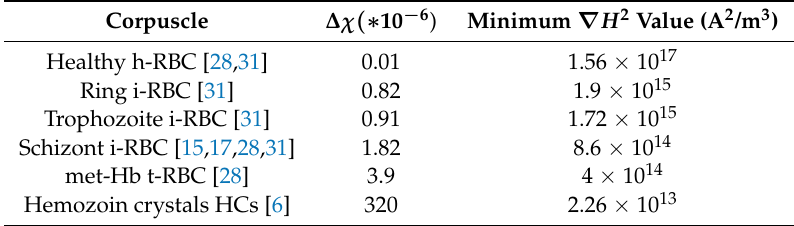
Table 1. Net magnetic susceptibilities of hemozoin and RBCs with respect to